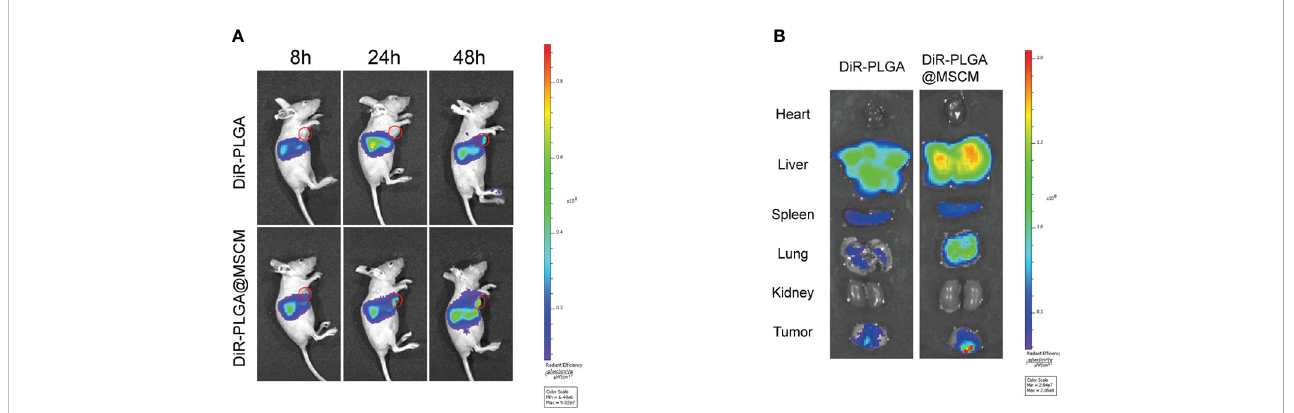
FIGURE 5 Biodistribution of the nanoparticles in vivo and in vitro . (A) Whole-body fl uorescence images of mice with subcutaneous MG63 xenograft tumors at 8, 24 and 48 hours after DiR-PLGA and DiR-PLGA@MSCM NP injection. (B) In vitro images of the tumor, heart, liver, spleen, spleen, lung and kidney at 48 hours after injection of DiR-PLGA and DiR-PLGA@MSCM NPs.